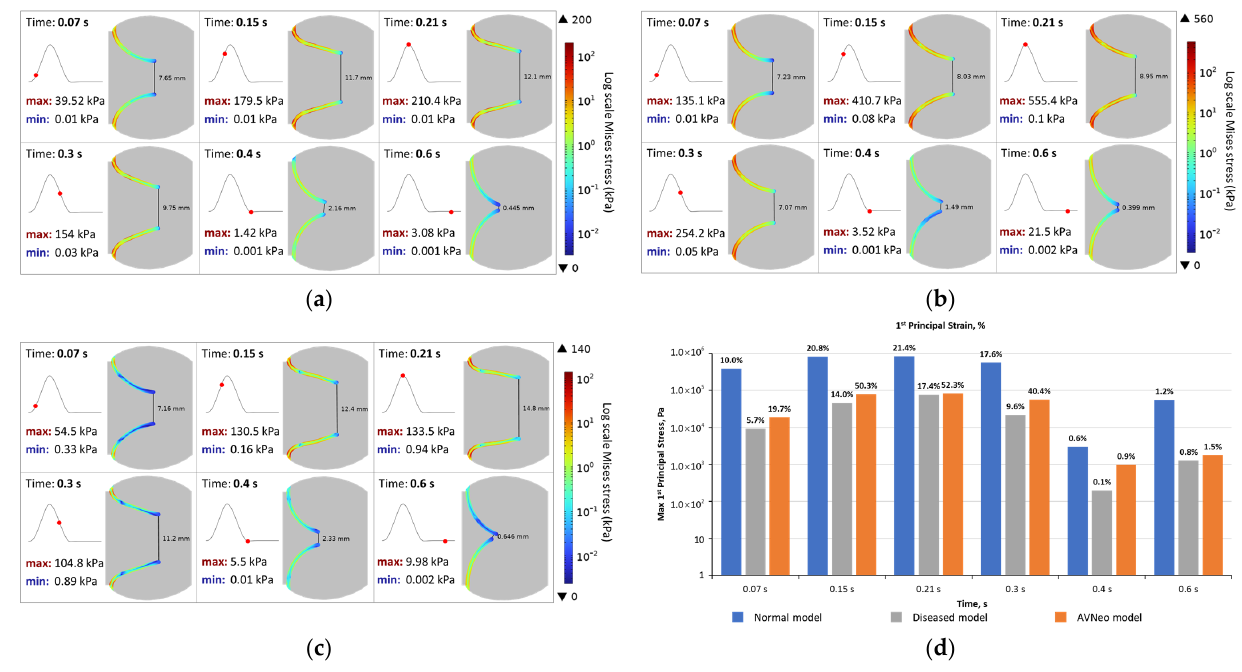
Figure 6. von Mises stress and minimal distance between leaflets for ( a ) healthy state, ( b ) diseased model, ( c ) AVNeo model, and ( d ) maximum first principal stress and strain. Time points are shown with red dots on the cardiac cycle. Von Mises stress is shown on a logarithmic scale with maximum and minimum values.